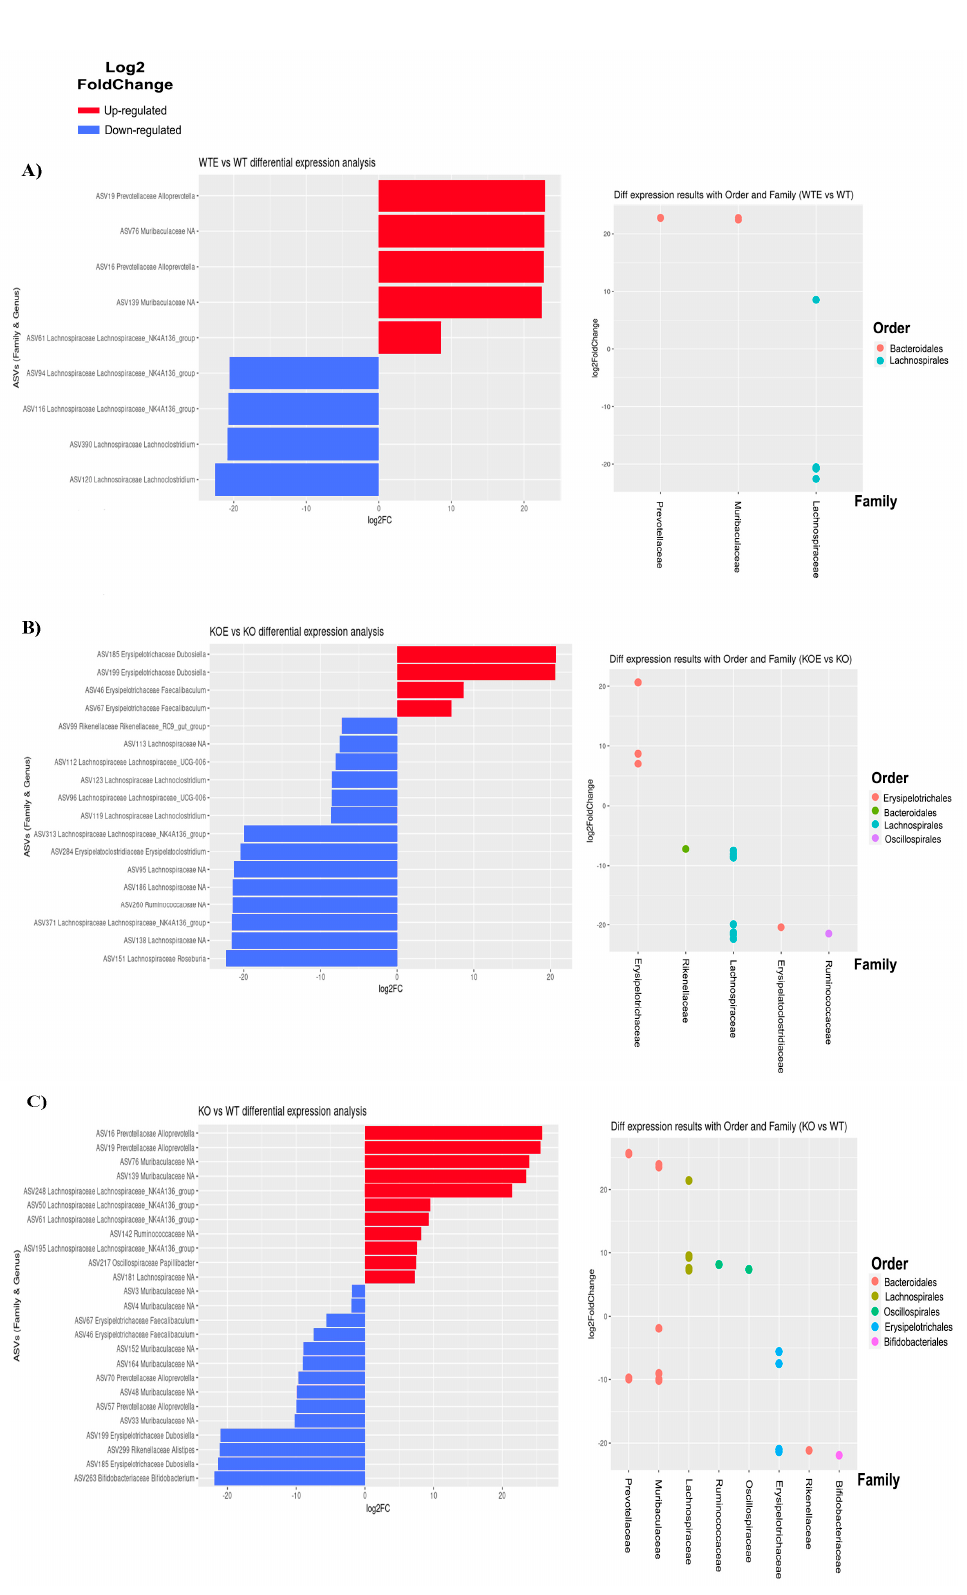
Figure 6. Differential expression analysis in bacteria order, family, and genus among groups. Log 2 fold change bars with statistically different expressed ASVs among groups. Each ASV with one species, nine in WTE vs. WT, 18 in KO vs. KOE, and 25 in KO vs. WT. Red and the right position indicate enriched species, and blue and the left position denote depleted species. ( A ) WTE vs. WT, ( B ) KOE vs. KO, and ( C ) KO vs. WT order, family, and genus comparisons. Tests for the differential expression were done using the DESeq2 package. Only the ASVs with an adjusted p -value <0.01 are shown. Ethanol impacted nine specific ASVs when comparing the WTE and WT mice. Figure 6A shows a large increment in the Alloprevotella genus and the Muribaculacetae family (Bacteroidota phylum) and a decrease in the different species of Lachnoclostridium and the Lachnospiraceae_NK4A136_group in the Lachnospiraceae family (Firmicutes phylum). However, in one of these genera (ASV61), ethanol treatment lowered their levels. Bacteria abundance in TLR4-KOE vs. TLR4-KO was then compared (Figure 6B). This comparison showed that 18 specific ASVs were statistically affected. Alcohol consumption increased the Erysipelotrichaceae family in two separate genera: Dubosiella and Faecalibaculum . In contrast, ethanol induced a negative effect on the Ruminococcaceae family, the Rikenellaceae_RC9_gut_group and the Erysipelatoclostridium genera, and on several genera of the Lachnospiraceae family ( Lachnospiraceae_UCG-006 , Lachnoclostridium , the Lachnospiraceae_NK4A136_group , and Roseburia , among others). It is interesting to note in the TLR4-KO mice that the significant changes in bacterial species induced by ethanol consumption were predominantly negative, with the biggest decrease in the Roseburia genus. The genotype effect was evaluated last, by comparing TLR4-KO vs. WT. Figure 6C reveals a complex contrast between both genotypes, with 25 specific ASVs showing a statistically different expression. This suggests that these two genotypes displayed higher bacterial diversity. The DESeq2 package revealed that the absence of TLR4 brought about major alterations to gut microbiome composition, and opposite effects on the same genus were even observed when comparing WT and TLR4-KO (Figure 6). For instance, in both the Muribaculaceae family and the Alloprevotella genus, there were different ASVs with contrasting deregulations (±10–20 log 2 fold change). The Ruminococcaceae family, the Lachnospiraceae_NK4A136_group , and Papillibacter genera were upregulated in the KO